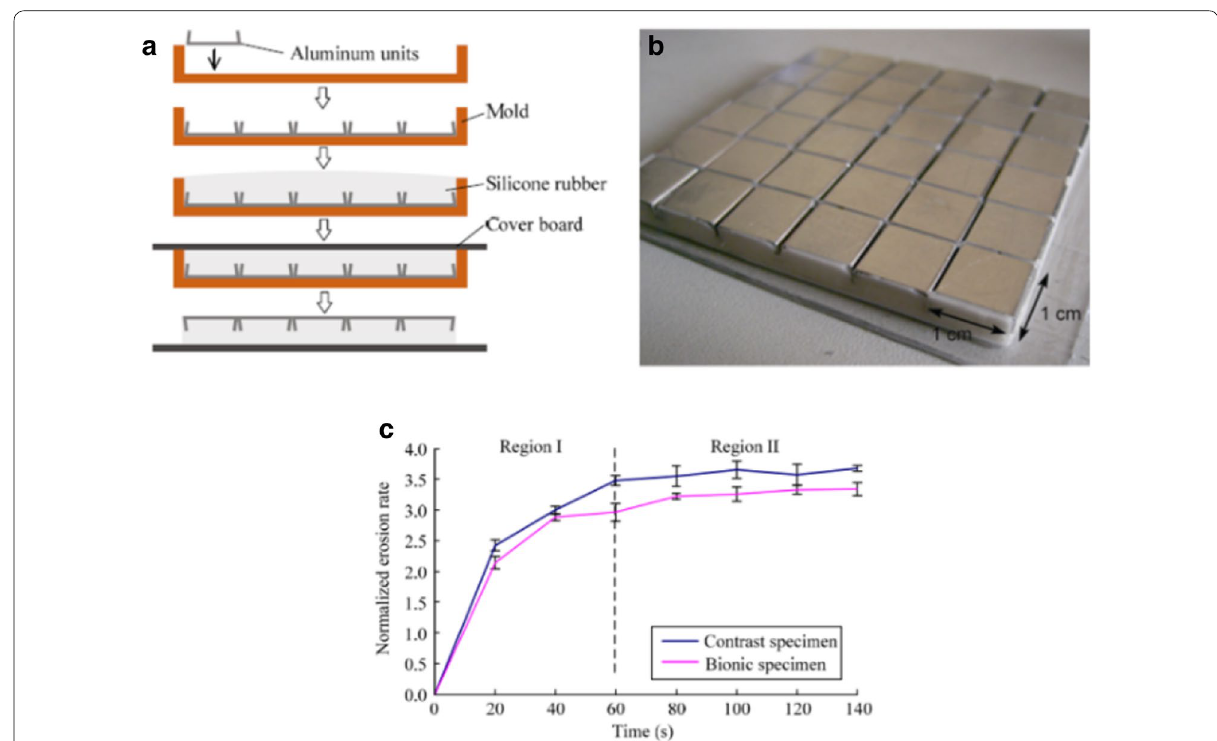
Figure 14 ( a ) The fabrication procedure of a bionic sample with the buffered structure [90]; ( b ) The bionic sample with the buffered structure [90]; ( c ) The erosion rate of the bionic sample with the buffered structure and a contrast sample